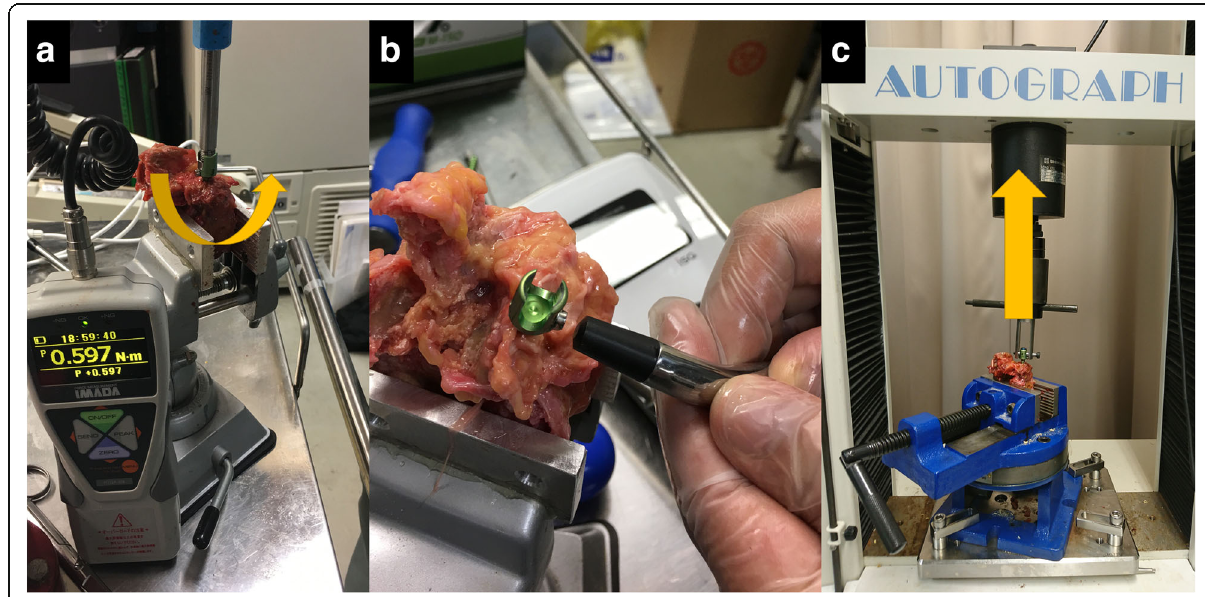
Fig. 2 Test force measurement. a Peak torque measurement. b Implant stability quotient value measurement. c Pull-out force